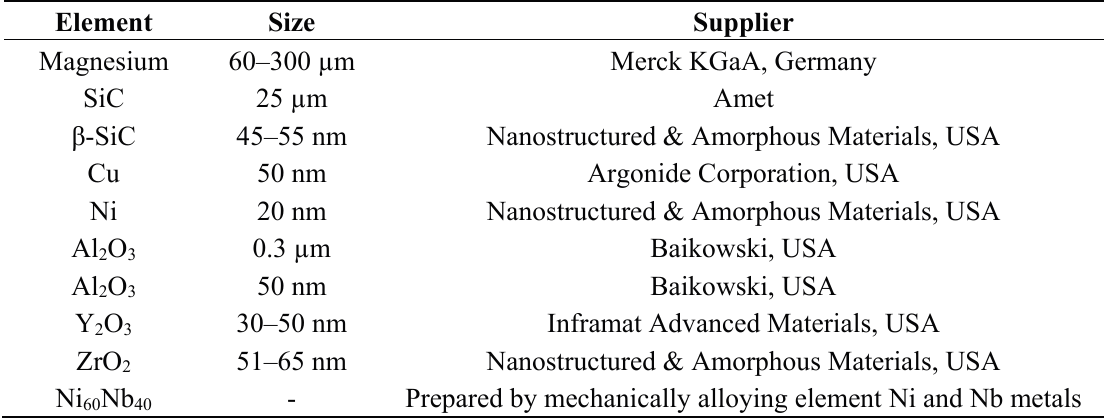
Table 1. Properties of matrix and